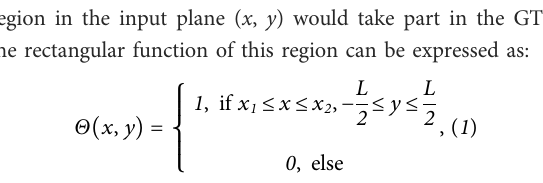
Figure 1, the system consists of two phase elements ( Ψ 12 and Ψ fi rst phase element Ψ “ transforming phase ” , 21 ). The 12 is called which achieves the conformal mapping of the beam. The incident beam in the rectangular region gradually curls up into a ring after being modulated by the transforming phase. The second phase element Ψ 21 is called “ correcting phase ” , which corrects the phase distortion caused by the beam curling at the output plane. It is important to note that the transforming and correcting phases are entirely unrelated to the input beam, thus the input parameters do not affect the transformation. This enables the conformal phase mapping without changing the output intensity distribution.